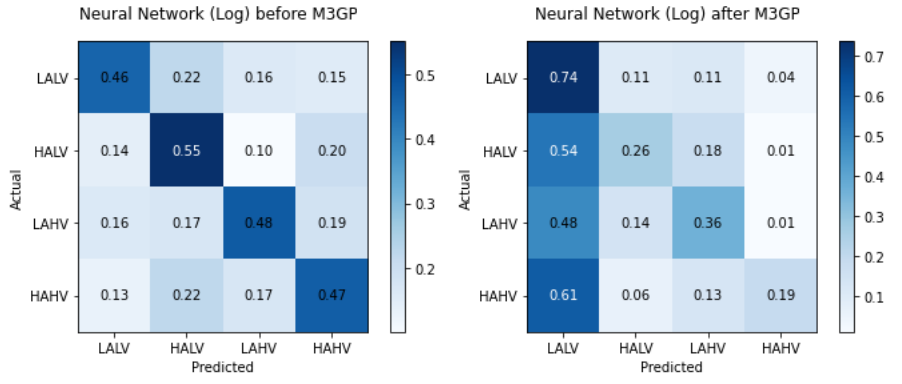
Figure 12. Classification results with Logistic (Log): on the left-hand side is the classification without treatment; on the right-hand side is the classification with the M3GP